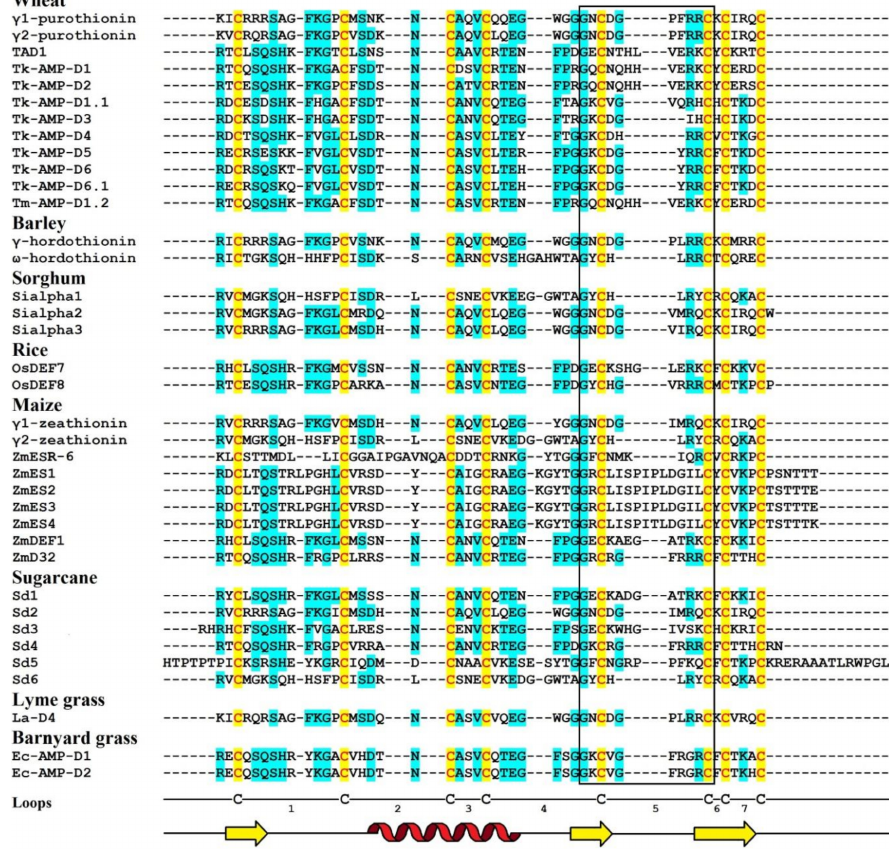
Figure 1. Amino acid sequences of characterized grass defensins. Cysteine residues are shaded yellow, while identical amino acids are shaded cyan. Loops defined as regions between cysteine residues [41] and the position of β -strands (yellow) and the α -helix (red) are indicated below the figure. A black frame borders the γ